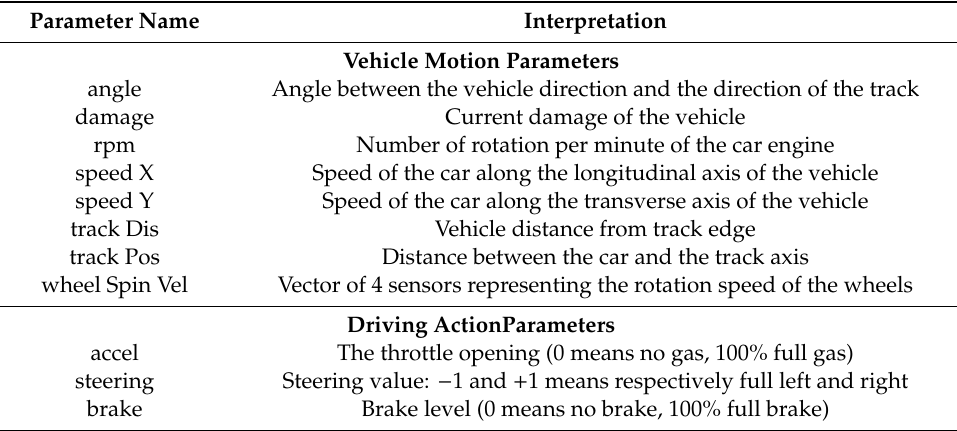
Table 1. Manual driving acquisition